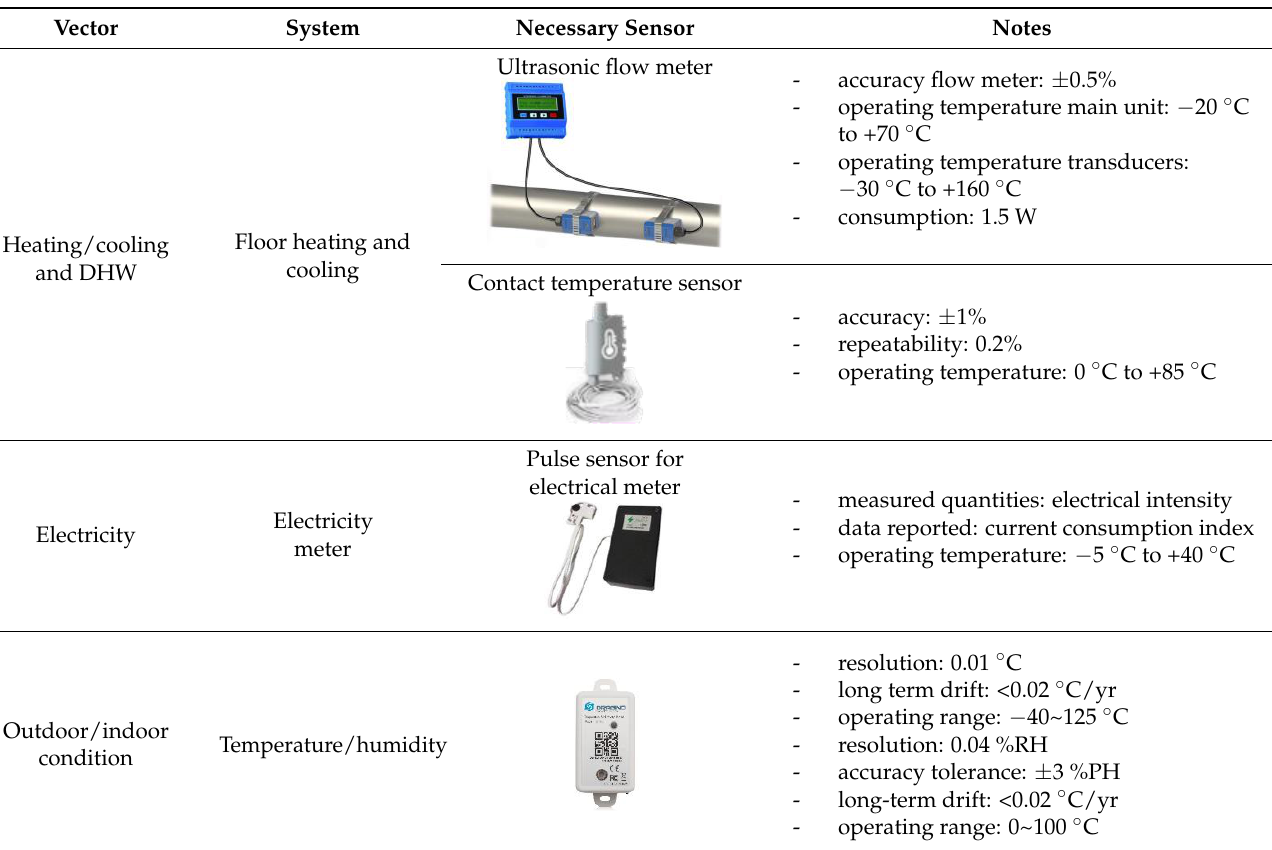
Table 4. Sensors kit for the Italian demo site, according to configuration n.6.